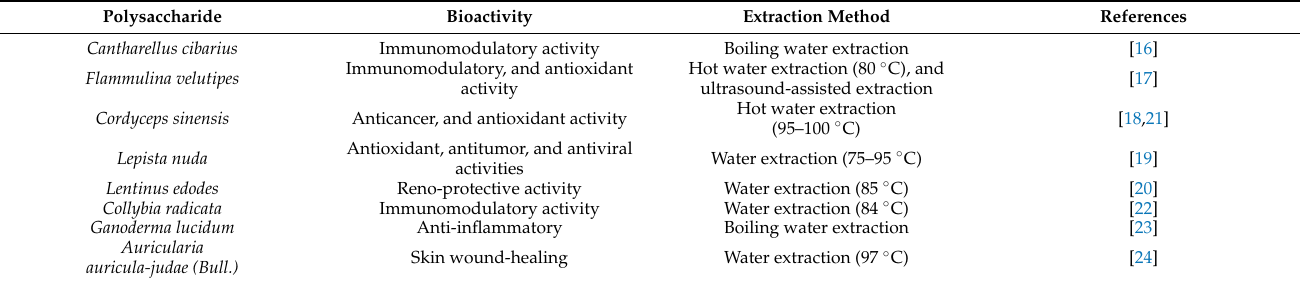
Table 1. Extraction methods, and bioactivities of polysaccharide from